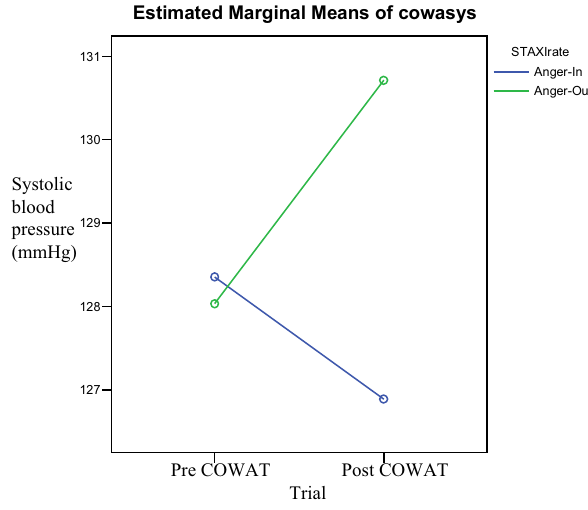
Fig. 1 COWAT systolic blood pressure, group by time interaction